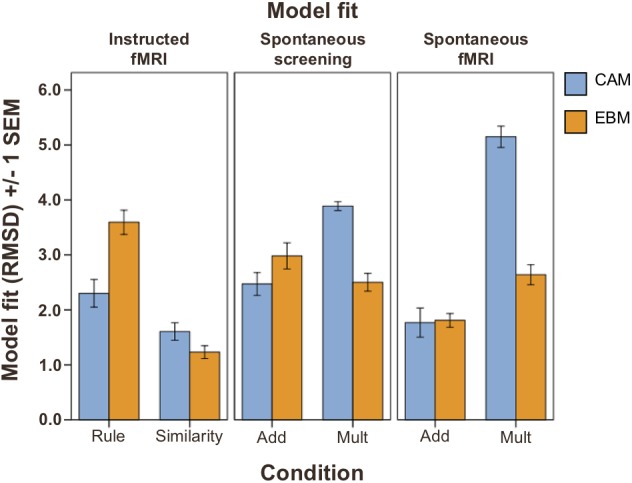
Model fit (RMSD; lower values indicate better model fit) on test phase judgment data (Total n = 74). Left panel: instructed strategies conditions (n = 38); middle and right panel: spontaneous strategies conditions (n = 36). Blue bars: fit of the CAM model. Orange bars: fit of the EBM model. Rule, instructed to use rule-based strategy. Similarity, instructed to use similarity-based strategy. ADD, additive learning environment inducing rule-based processing (see section “Materials and Methods”). MULT, multiplicative learning environment inducing similarity-based processing (see section “Materials and Methods”). Error bars denote ±1 SEM.